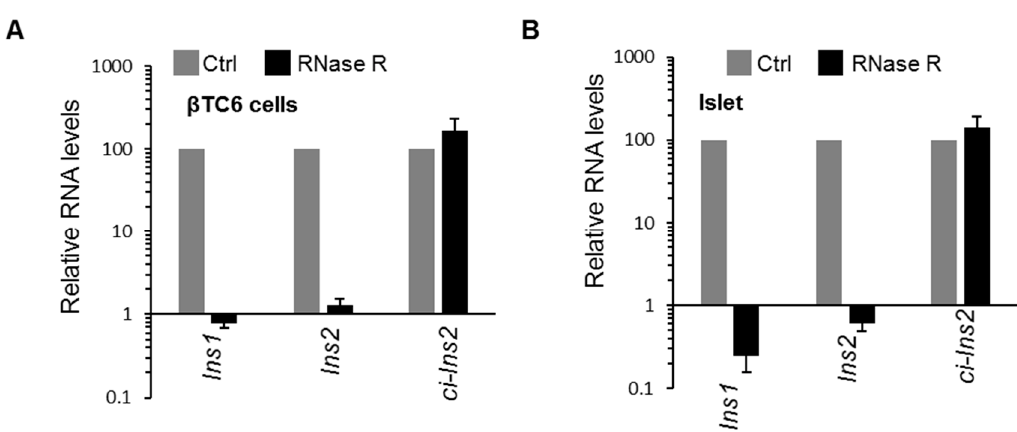
Figure 3. Circular nature and stability of ci-Ins2 . ( A , B ) RT-qPCR analysis showing the levels of mRNAs and ci-Ins2 upon RNase R treatment in β TC6 cells ( A ) and pancreatic islets ( B ). Data represent the means ± SEM from three independent experiments.